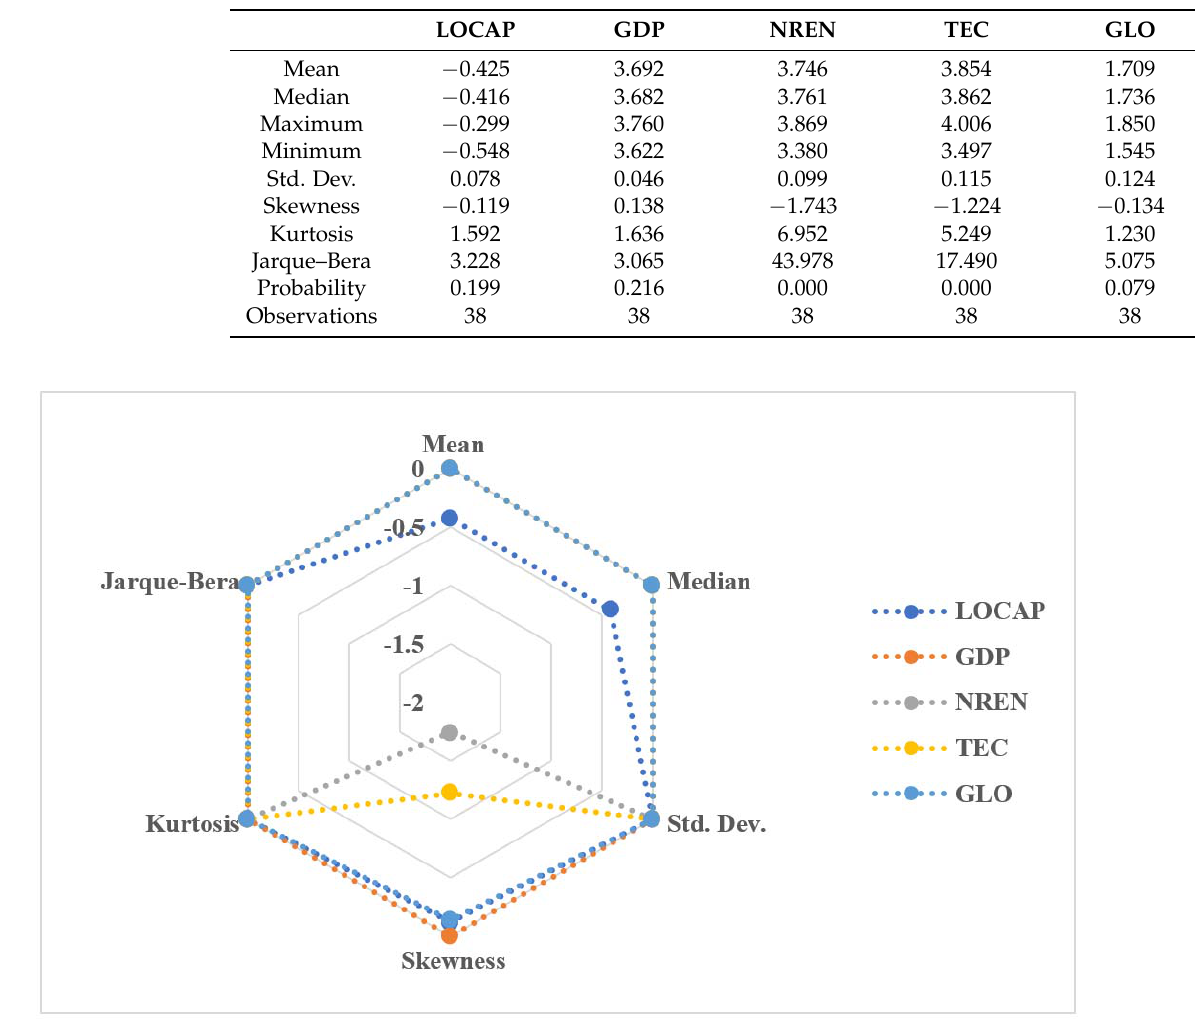
Figure 2. RADAR chart.